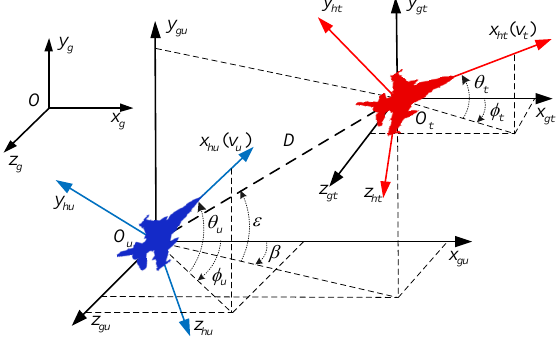
Figure 3. Engagement geometry relationship between the UCAV and the